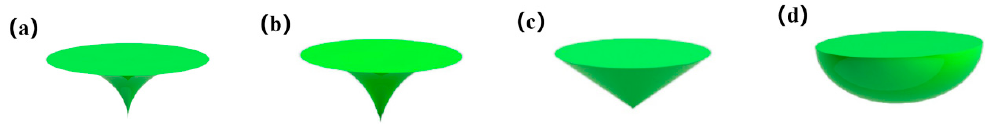
Figure 9. Schematic of different light coupling structures: ( a ) cone shape, ( b ) circle shape, ( c ) inverted triangle shape, ( d ) concave shape.